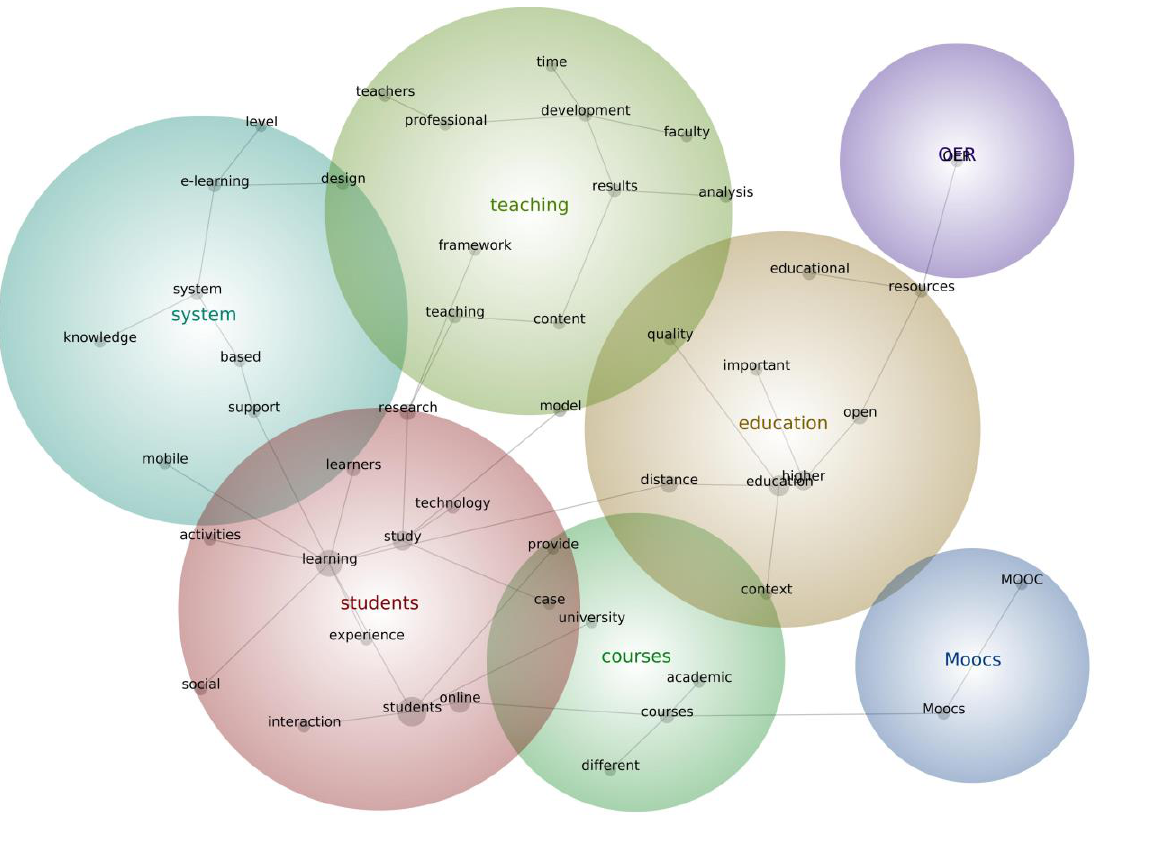
Figure 4. Concept map of MOOCs and OER